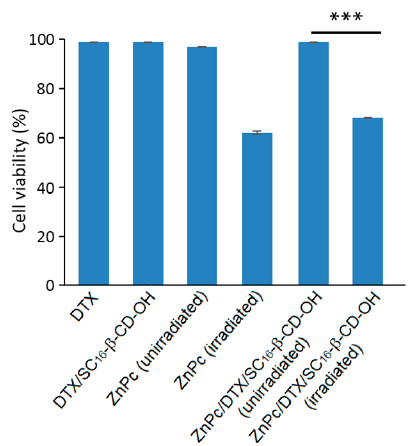
Figure 41. HeLa cell viability (MTS assay, *** p < 0.01 by Student’s t -test) in the dark and after light irradiation ( λ = 340 nm, 5 J/cm 2 , 30 min). The cells were treated with free DTX, free ZnPc, DTX/SC 16 - β -CD-OH nanoparticles (NPs), and ZnPc/DTX/SC 16 - β -CD-OH NPs (10 µg/mL for all samples) and collected at 24 h. Adapted from Conte; Scala; Siracusano; Sortino; Pennisi; Piperno; Miro; Ungaro; Sciortino; Quaglia; Mazzaglia [167].